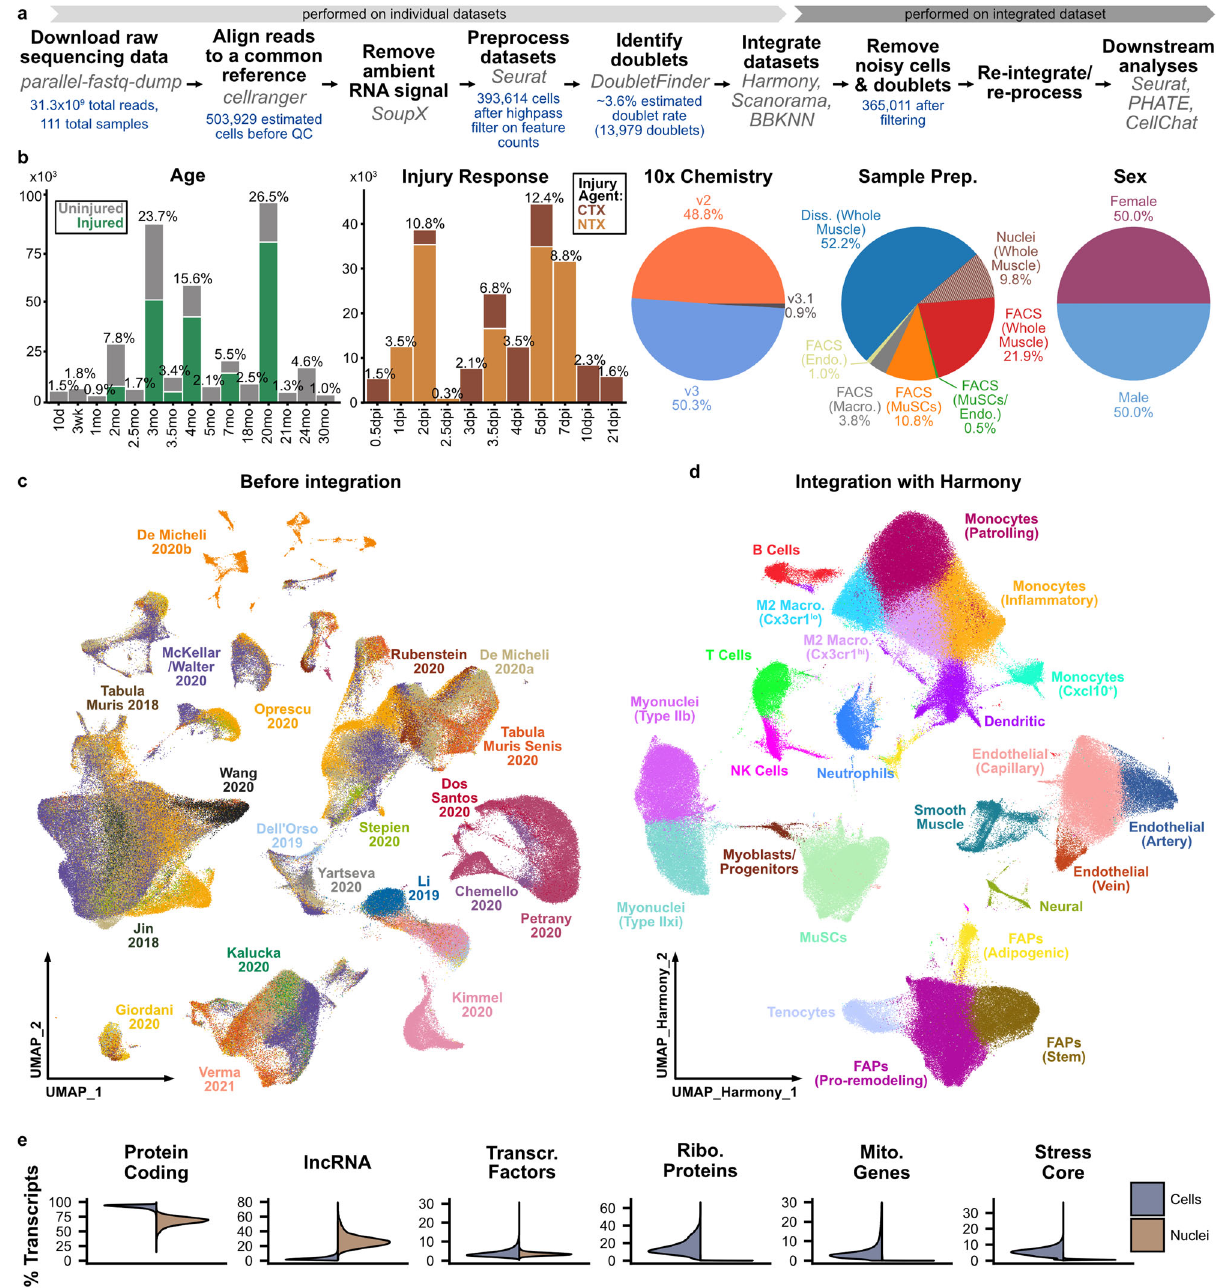
Fig. 1 Large-scale integration of 111 single-cell and single-nucleus RNAseq samples reveals cell subtypes in skeletal muscle. a Work fl ow used for preparation, integration, and analysis of sc/snRNAseq compendium (see “ Methods ” ). b Overview of experimental and technical variables across compendium. The percentages shown are calculated with respect to cell number after quality control. Ages in months (mo). Injury by cardiotoxin (CTX) or notexin (NTX). Time-points in days post-injury (dpi). See also Table S1. c UMAP representation of the merged datasets after alignment, ambient RNA removal, quality control fi ltering and doublet removal, but before batch-correction, colored by the dataset source. d UMAP representation of integrated compendium after batch-correction with Harmony. Cells are colored by cell type, identi fi ed after Harmony integration (Fig. S3). e Differential detection of gene biotype sets between single-cell and single-nucleus datasets, including all protein-coding genes, long noncoding RNAs (lncRNAs), transcription factors, cell surface proteins, ribosomal protein subunits, mitochondrial genes, and “ core ” dissociation-associated stress